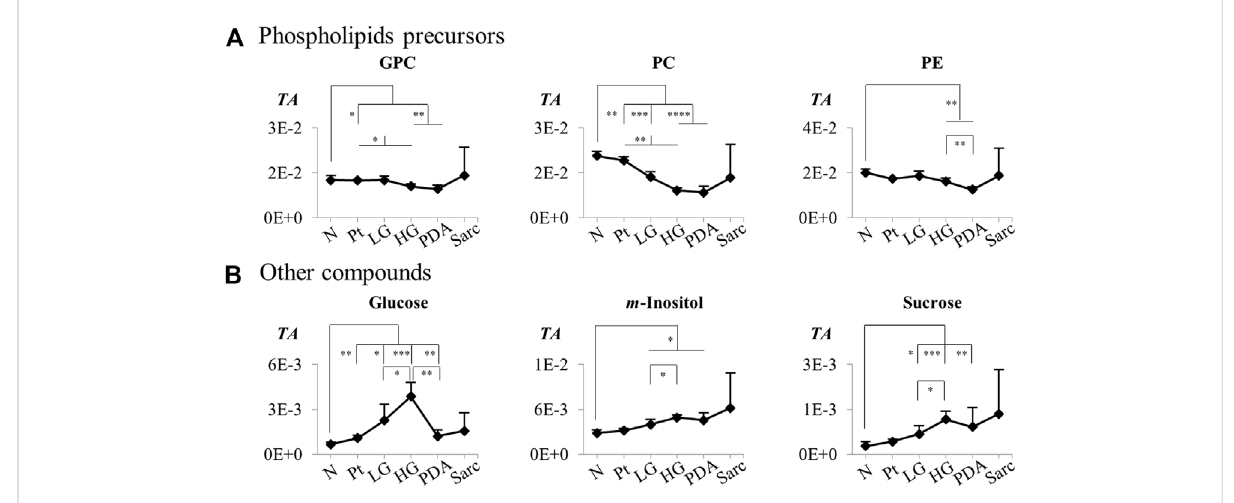
FIGURE 6 Variations in (A) phospholipids precursors and (B) other compounds across pancreatic cancer progression, represented as normalized peak integrals inrelation to totalspectra area(TA). Abbreviations as de fi ned incaptionof Figure 1 and SupplementaryTable S1. Asterisks indicate